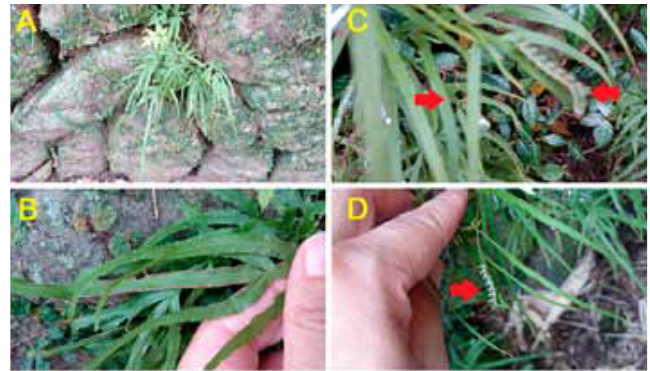
Fig. 2 - Pteris multifida growing on the stone wall in a private gar- den (Kiyotake-cho, Miyazaki, Japan). (A) Top view of grow- ing plants. (B) Spore-bearing adaxial side of the leaves. (C, D) Plants being fed on by caterpillars of Callopistria japonibia . Arrows indicate the presence of